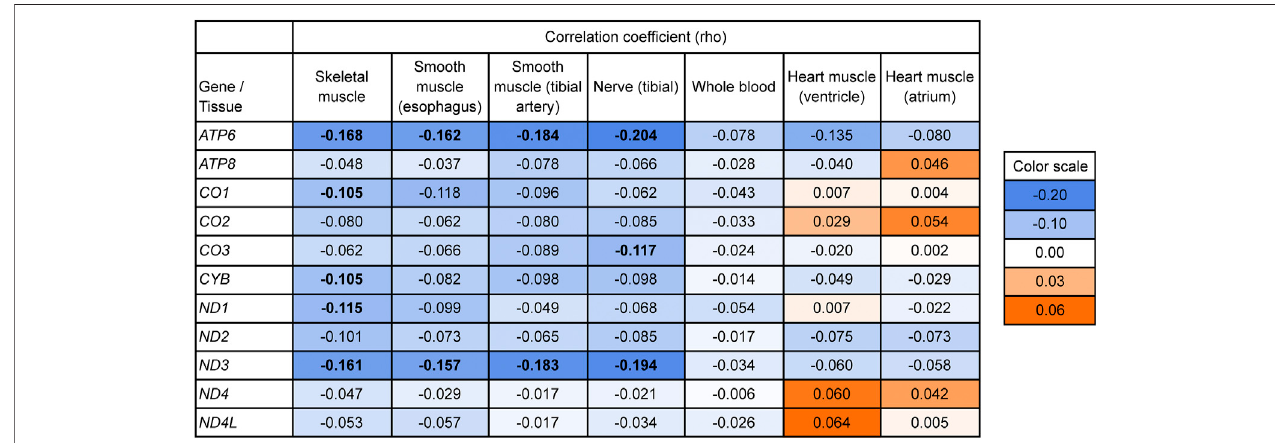
FIGURE 4 | Testing the relationship between mitonuclear DNA discordance and mtDNA gene expression (adjusted for age and ischemic time) using a one-sided Spearman ’ s rank-order correlation. Bold values indicate Bonferroni-corrected signi fi cant results ( p < 0.05). p -values are listed in Supplementary Table S3 . Values on the blue background indicate lower adjusted expression with higher mitonuclear DNA discordance, consistent with our hypothesis; values on the orange background indicate higher adjustedexpression withhigher mitonuclearDNA discordance.Thebackgroundisdarkerwithincreasing effect.Bonferronicorrection accountsfor multiple hypothesis testing across the 11 mtDNA protein-coding genes analyzed.